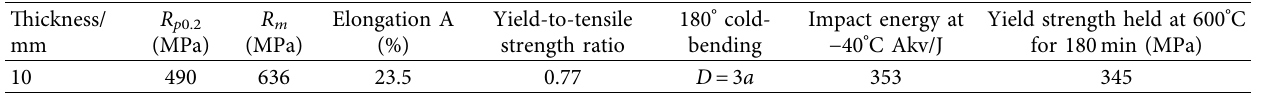
Table 2: Mechanical behavior the fre-resistant steel plate.